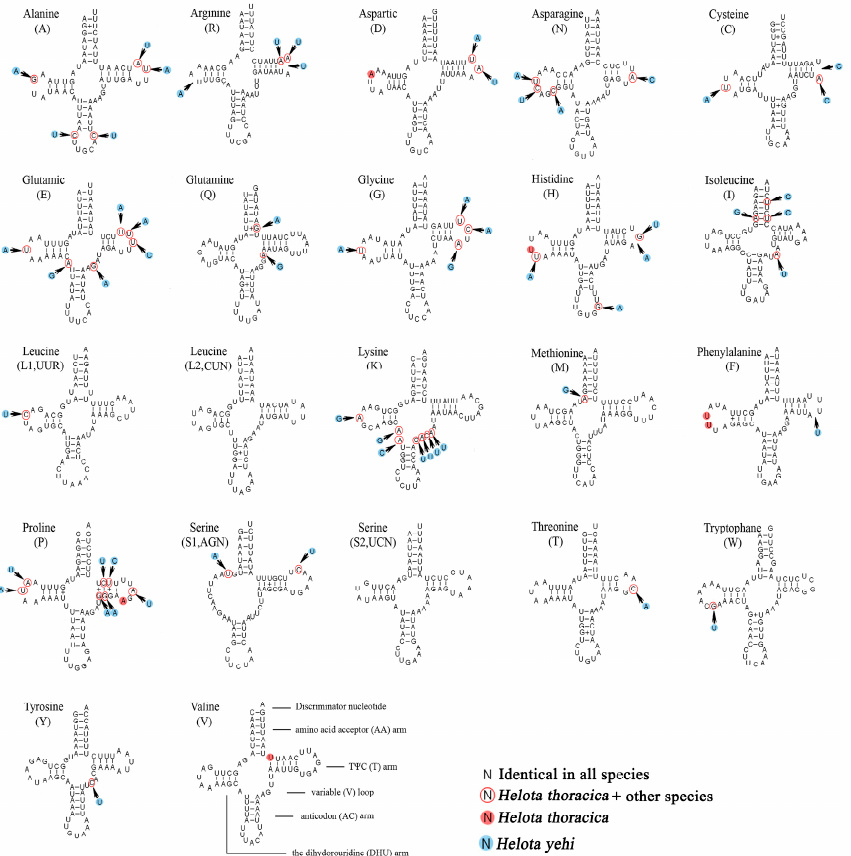
Figure 5. Inferred secondary structures of 22 tRNAs of H. thoracica and H. yehi . The tRNAs are labeled with the abbreviations of their corresponding amino acids. Dash (–) indicates Watson–Crick bonds and symbol (+) indicates GU bonds.